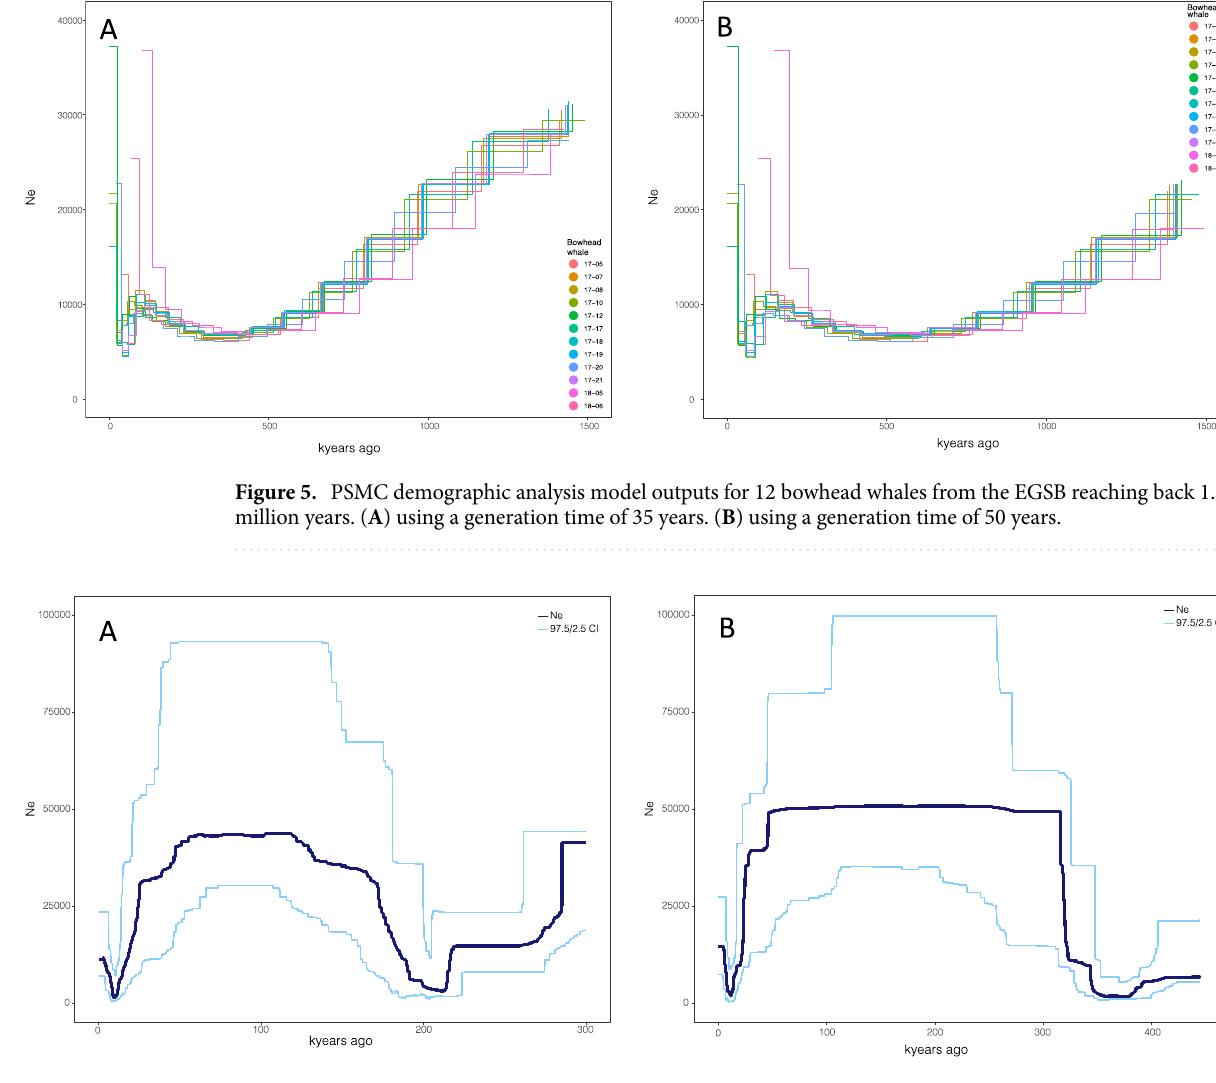
Figure 6. Stairway plot of the more recent demographic history of the EGSB stock with 2.5 and 97.5% confidence intervals. A: using an unfolded and B: using a folded site frequency spectrum as input. Generation time was set to 35